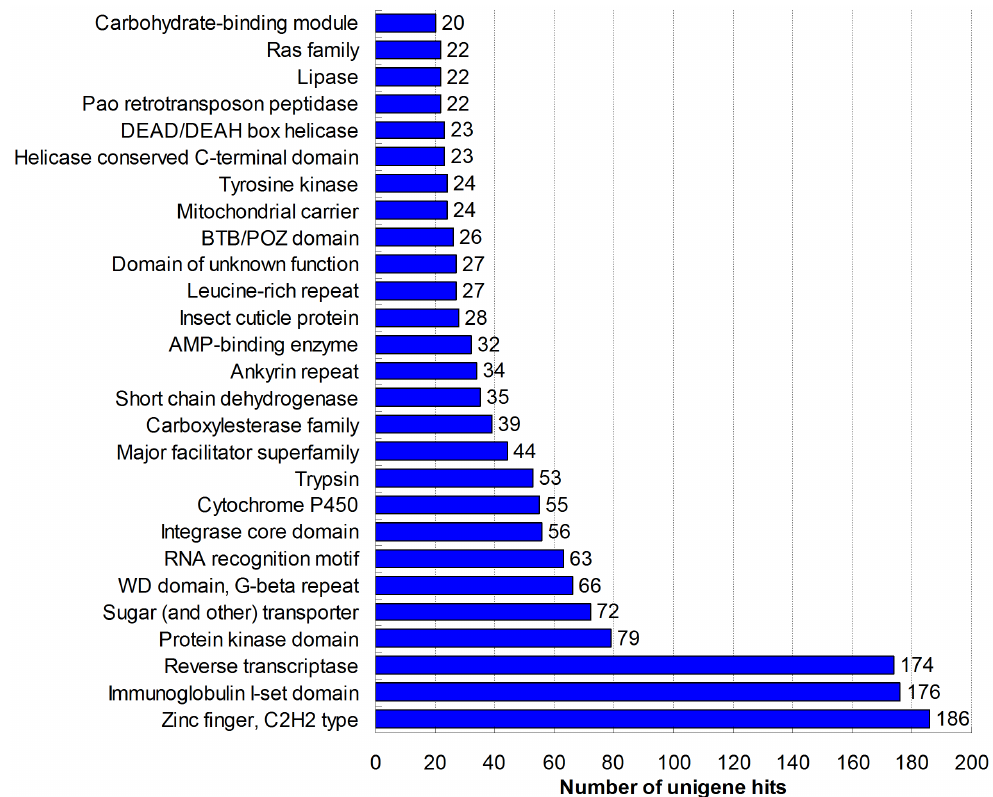
Figure 3. Top 27 Pfam domains predcted in translated unigenes.